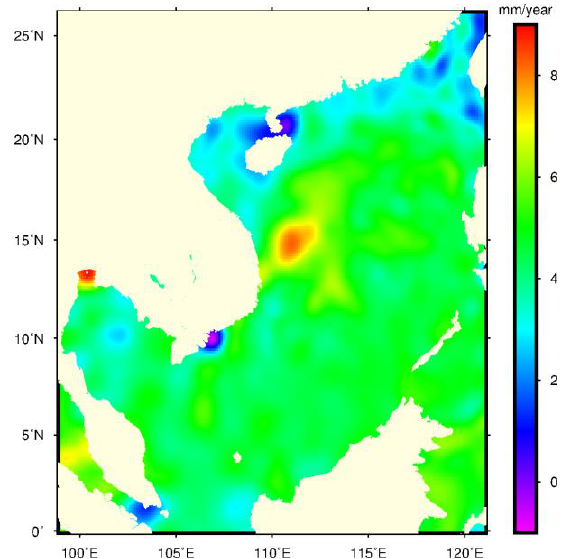
Figure 6. Satellite altimetry linear trend spatial variability in the SCS